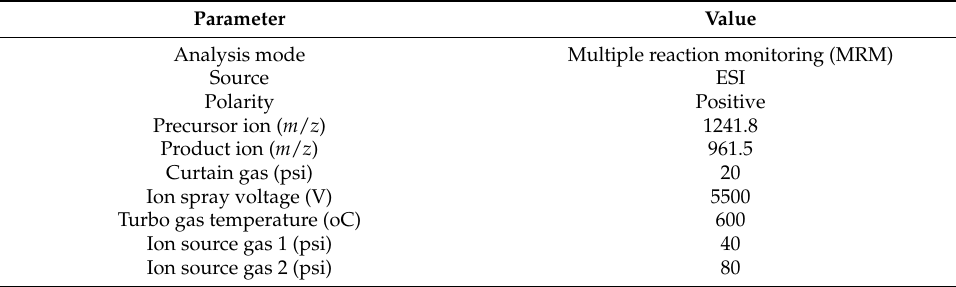
Table 3. Analytical conditions of